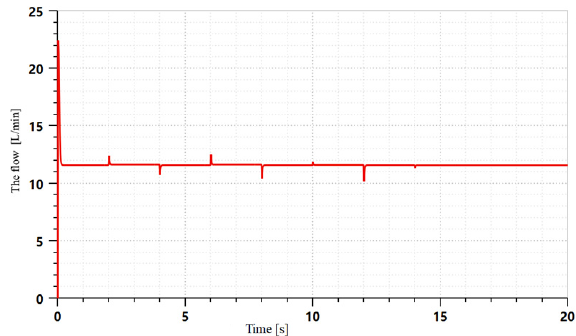
Figure 16. Viscous damping coefficient of 1000 N/(m·s).